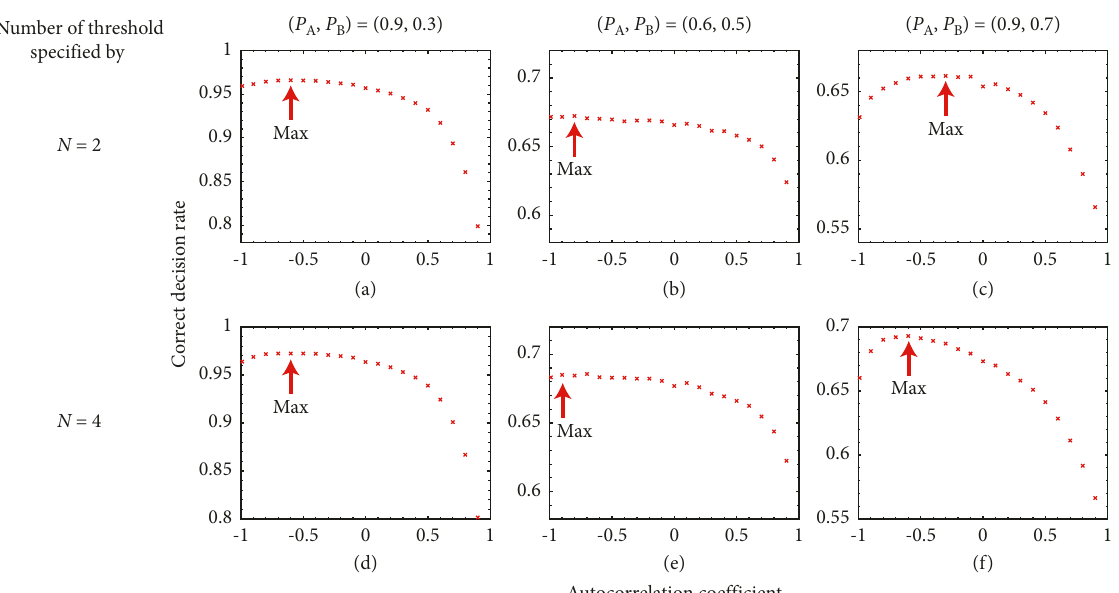
Figure 2: Correct decision rate at t � 1000 as a function of the autocorrelation coefficient λ in various reward environments and a different number of threshold levels. It is to be noted that the maximum performance is obtained by negatively correlated time series.